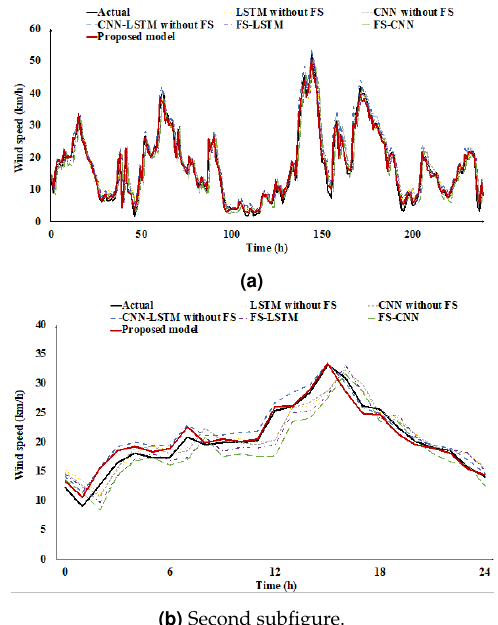
Fig. 6 illustrated the comparative performance of these models. It can be seen from Fig.6a that the forecasting of all models considerably followed the actual value in a long time. Fig.6b drew the forecasting results in one day. On the one hand, with the slightly variation of wind speed, for instance from 18h to 24h in Fig. 6b, almost all comparative models produced good results. On the other hand, when the wind speed suddenly changed, for example during 6h-18h, the forecasting results of single models of LSTM and CNN with or without FS were lagged while the hybrid models (FS-CNN-LSTM and CNN-LSTM without FS) showed the best adaptation to these changes and were closest to the black line (actual). Table 3 showed two evaluation indicators of RMSE, and MAPE obtained from the forecasting results using 6 mod- els. The prediction results of single models, namely LSTM and CNN with or without FS were poor. For LSTM, the fig- ure of MAPE and RMSE were approximately 24% and 3.8 km/h, respectively, while that of CNN were 21%-24% and about 3.8 km/h, in that order. This could be due to the rela- tively simple network structure and the inability to learn more detailed features of these single models. Although CNN feature extraction could improve model learning to a certain extent, it had limited processing power for complex data fluctuations. Meanwhile, the accuracy of prediction of the hybrid models such as CNN-LSTM without FS and